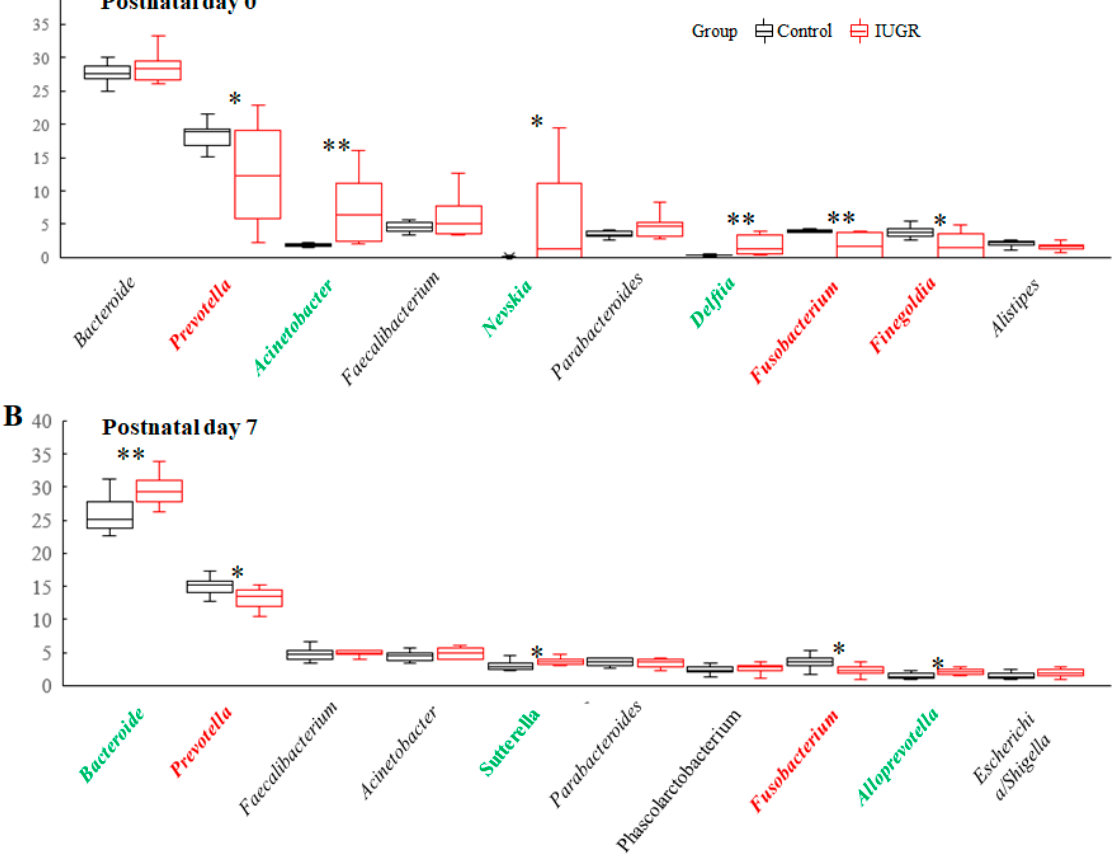
Figure 6. Relative abundances of the 10 most abundant genera in the lung microbiota of the control and IUGR groups on ( A ) postnatal day 0 and ( B ) postnatal day 7. On postnatal day 0, Acinetobacter , Nevskia , and Delftia were significantly enriched in the IUGR group, whereas Prevotella , Fusobacterium , and Finegoldia were significantly enriched in the control group. On postnatal day 7, Bacteroides , Sutterella , and Alloprevotella were significantly enriched in the IUGR group, whereas Prevotella and Fusobacterium were significantly enriched in the control group. Genera significantly enriched in the control and IUGR groups are labeled in red and green, respectively. n = 8–10 rats at each postnatal day. Data are shown as box-and-whisker plots. * p < 0.05, ** p < 0.01. Moreover, Acinetobacter and Delftia in the lungs and Acinetobacter and Nevskia in the gastrointestinal tract were significantly negatively correlated with the RAC (Figure 7A, p < 0.01) on day 0. Bacteroides in the lungs and Rodentibacter and Romboutsia in the gastroin- testinal tract were significantly negatively correlated with the RAC (Figure 7B, p < 0.01) on day